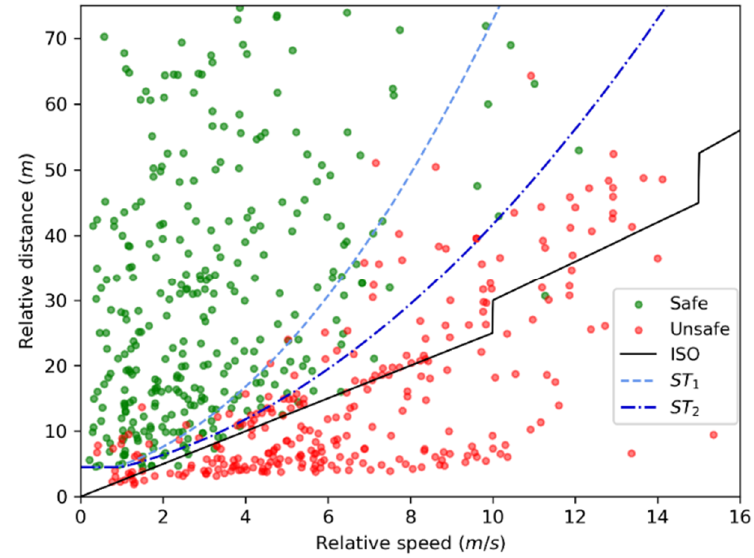
Figure 13. The comparison between the International Standards Organization (ISO) model and lane-change decision model .